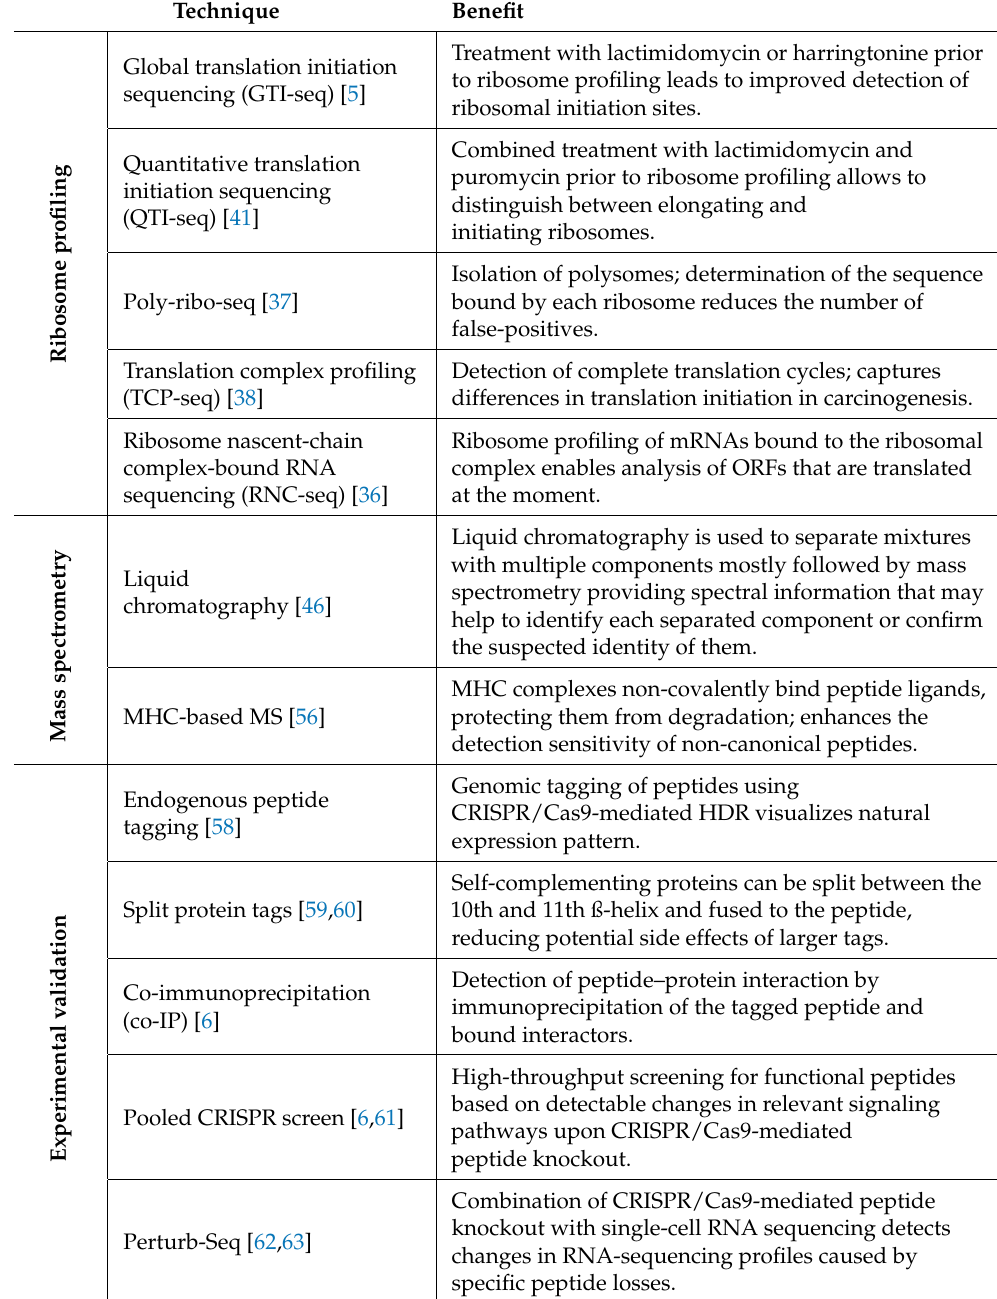
Table 2. Recent advances in peptide detection